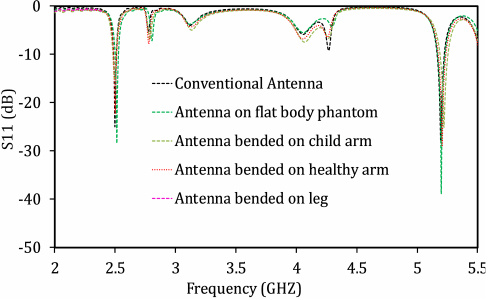
Figure 20. On-body return loss of conventional dual band